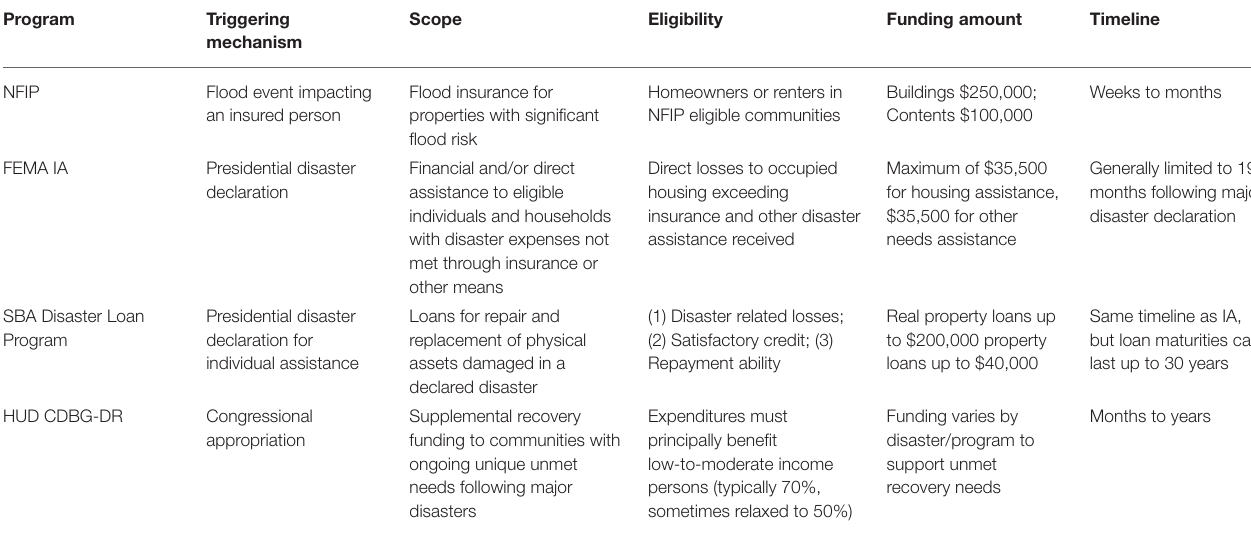
TABLE 1 | Federal programs providing direct support to households and individuals (Cecire and Jaroscak, 2019; Lindsay and Webster, 2019; Webster, 2019; Jaroscak,